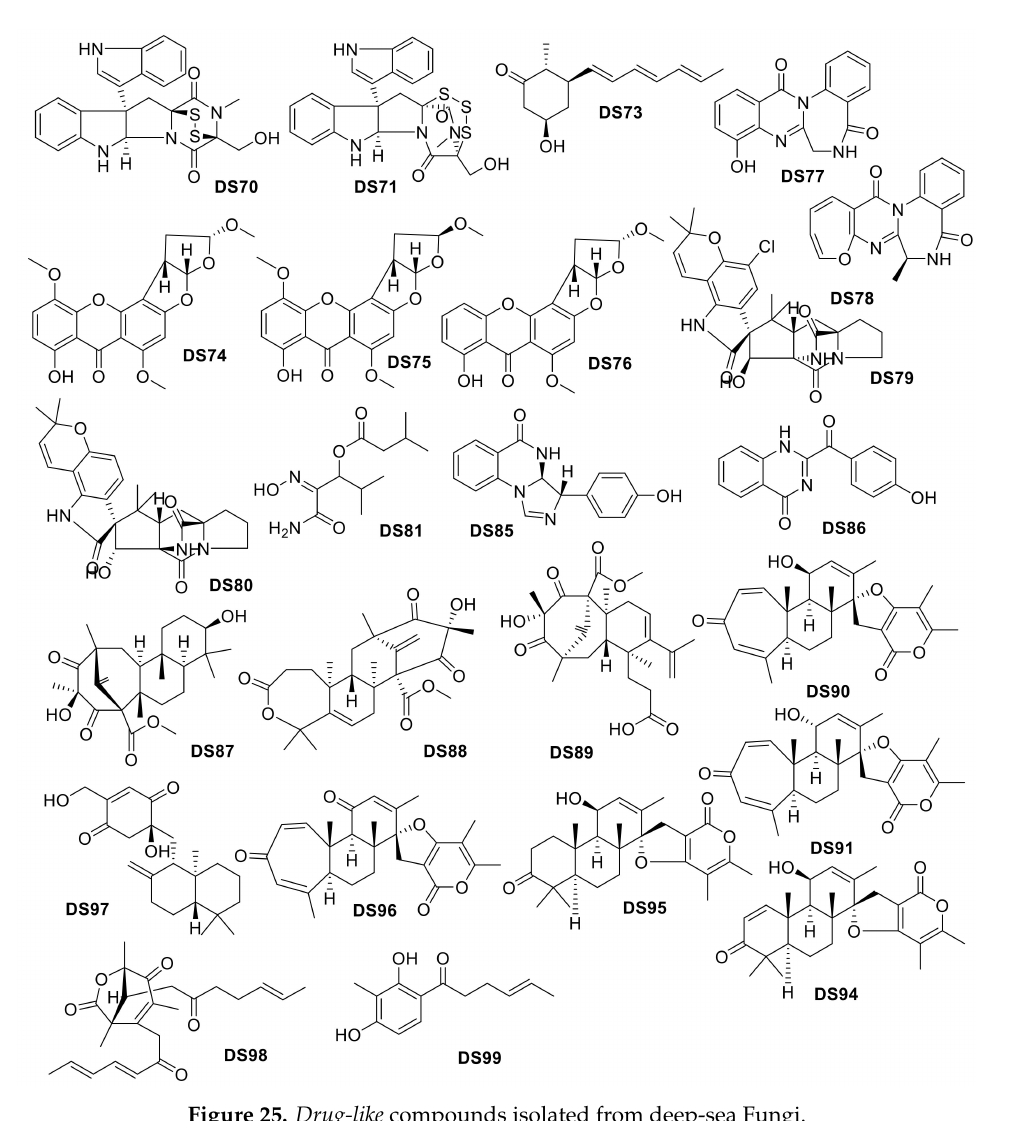
Figure 25. Drug-like compounds isolated from deep-sea